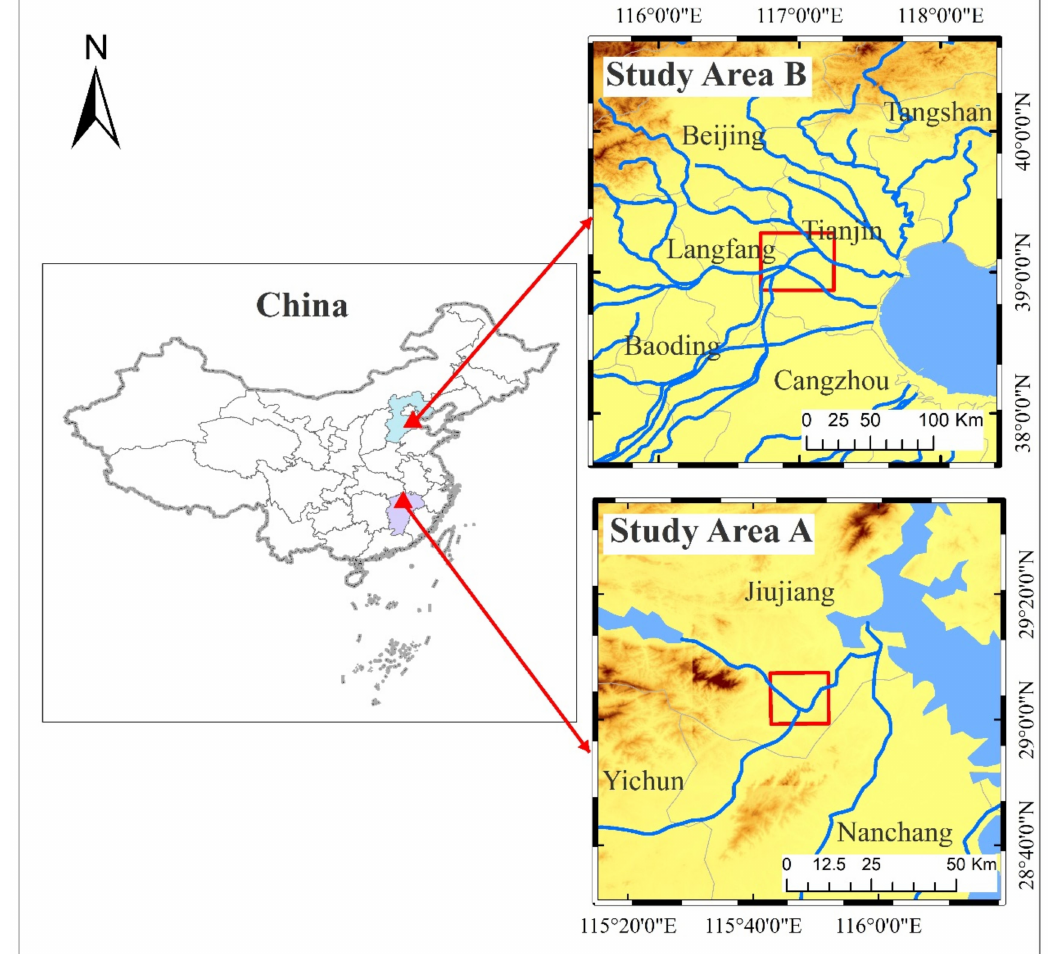
Figure 1. Location map of study areas. Study area A is located in Jiujiang, Jiangxi Province, while study area B is located in Langfang, Hebei